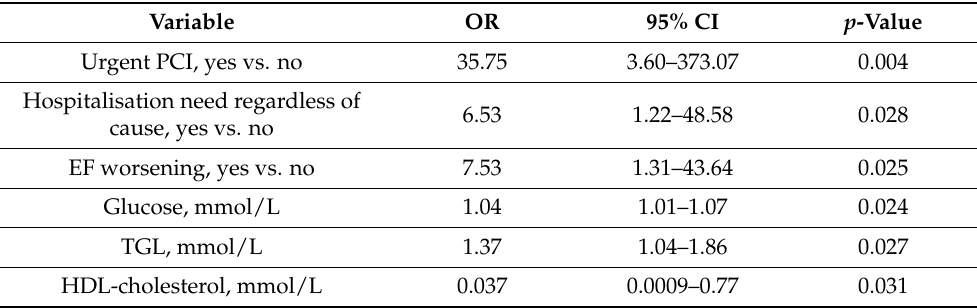
Table 4. Univariate analysis of MACE